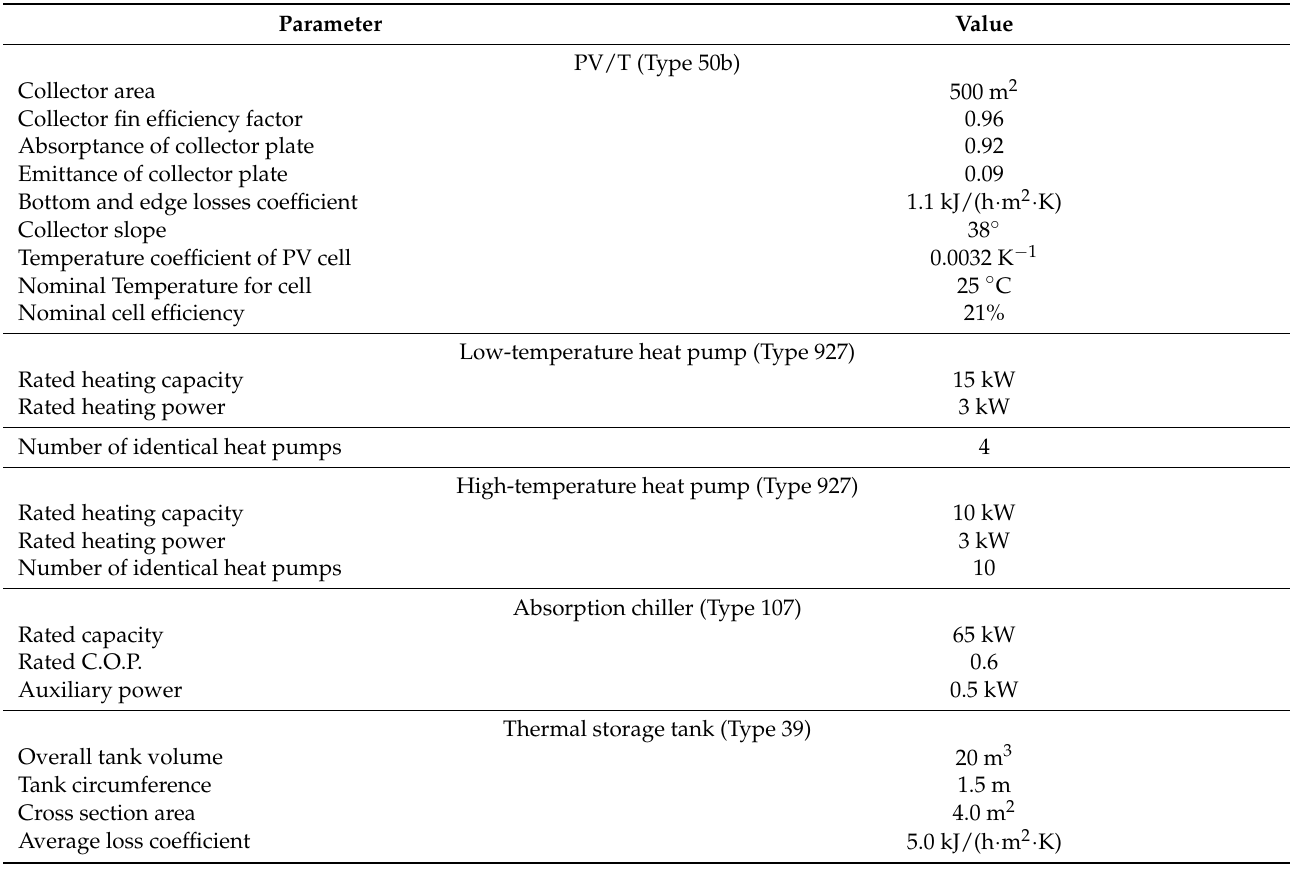
Figure 1. Schematic representation of solar tri-generation supply system. Table 1. The components and parameters of the